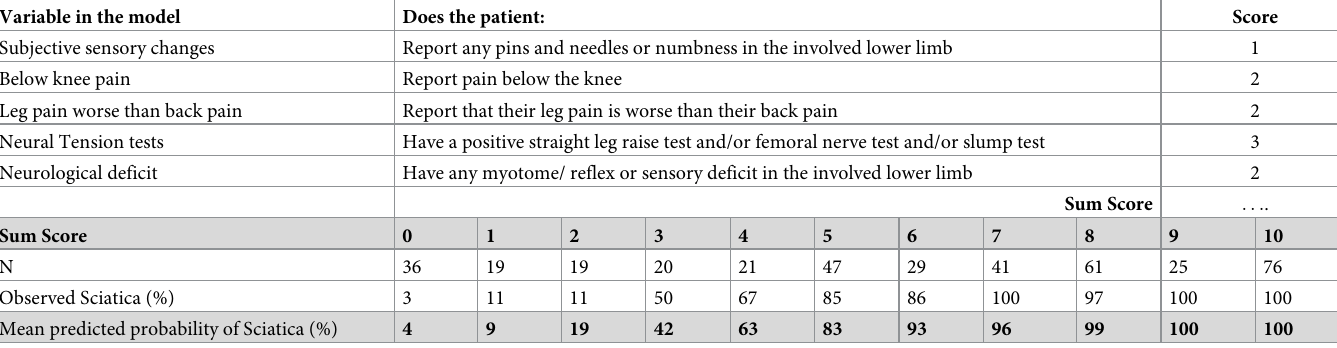
Table 4. Scoring tool based on model (i) for clinical assessment items and corresponding predicted probability of